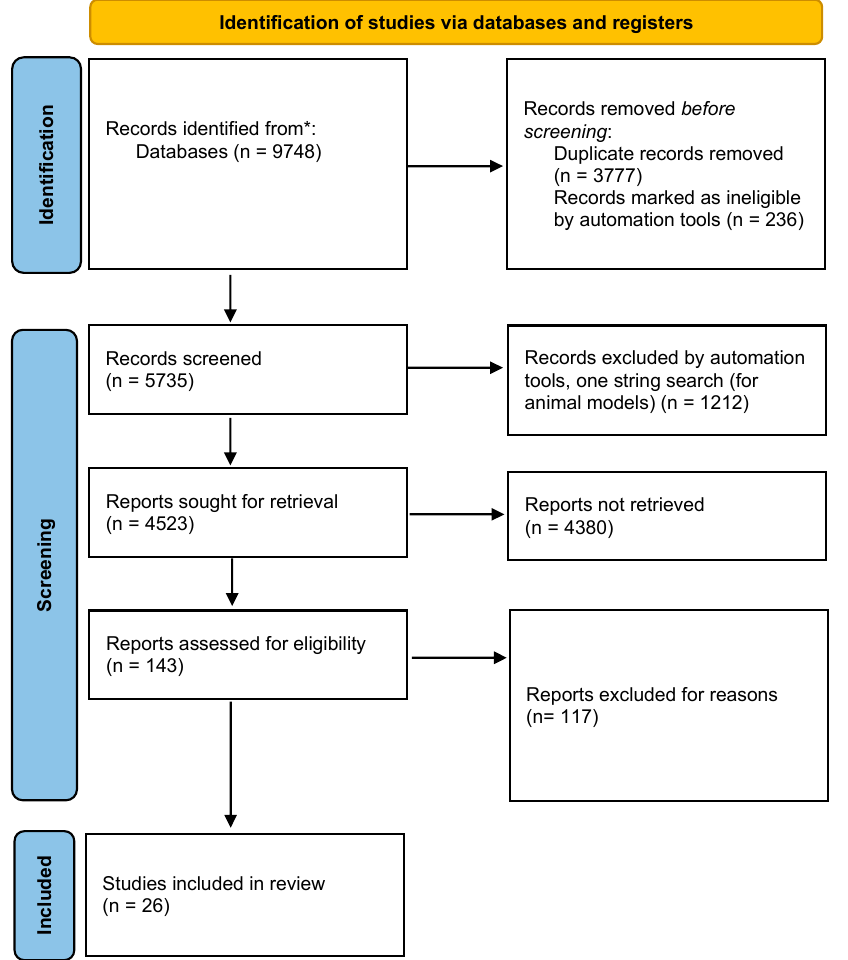
Figure 1. Study flow diagram. * Medline (PubMed) and Elsevier (ClinicalKey) databases, manual searches through reference lists of the recorded articles.